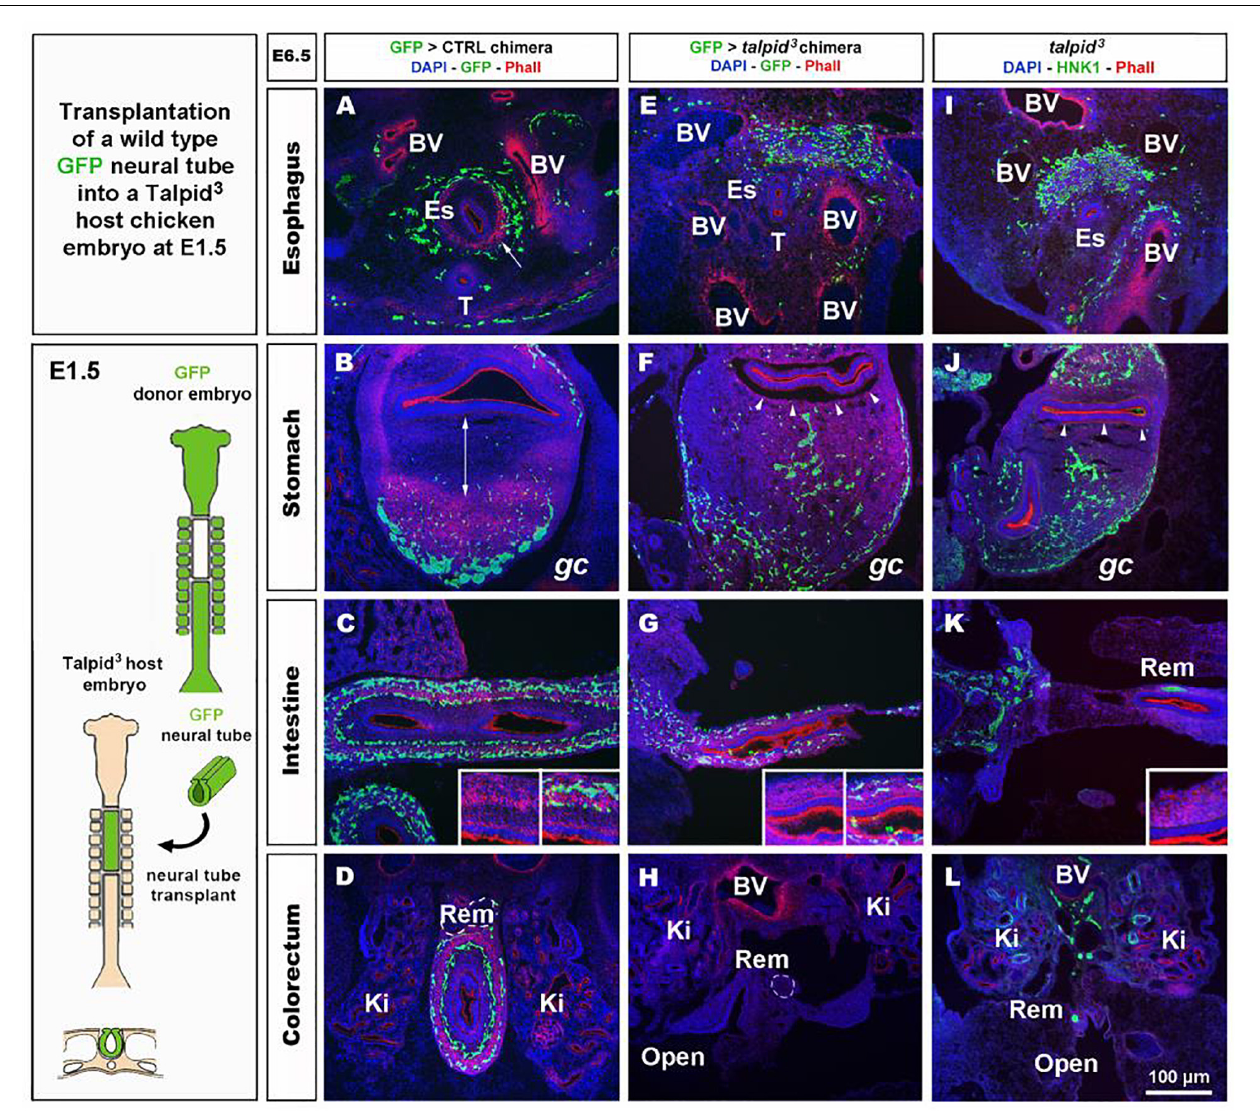
FIGURE 4 | GFP > talpid 3 chimeric embryos show ENS and smooth muscle patterning defects similar to stage matched talpid 3 embryos. (A–L) E6.5 chimeric embryos after wild type GFP neural tube transplantation in (A–D) GFP > control and (E–H) GFP > talpid 3 hosts, compared to (I–L) E6.5 talpid 3 embryos. (A–L) Immunofluorescent staining for GFP and Phalloidin in (A–H) chimeric embryos and (I–L) HNK-1 and phalloidin in talpid 3 embryos. ( E–G + inset) GFP > talpid 3 chimeric embryos have scattered ENCC distribution similar to TALPID3 embryos. (A–D) Phalloidin staining shows smooth muscle patterning in control chimera (arrow, double arrow, insets). (E–H) Phalloidin staining shows a lack of smooth muscle patterning in the GFP > talpid 3 chimera, similar to the staining found in talpid 3 embryos ( I–L ; arrowheads, inset). BV, blood vessels; Ki, kidneys; Rem, nerve of Remak; Es, esophagus; T, trachea; gc , greater curvature of the stomach. Same scale bar in (A–L)